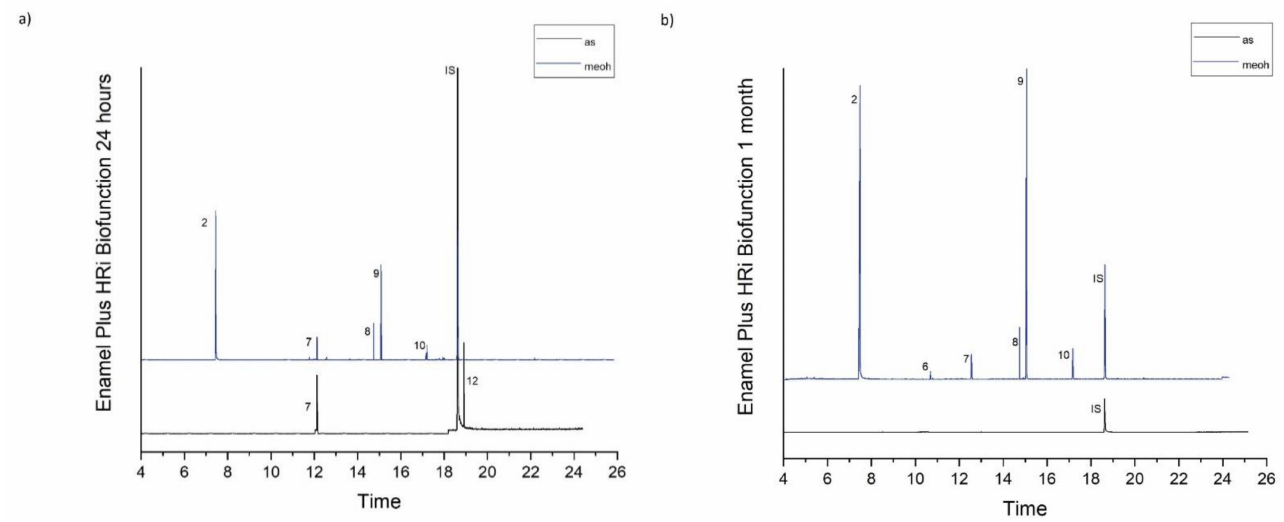
Figure 3. ( a , b ). Chromatograms of Enamel Plus HRi Biofunction in artificial saliva and methanol for both observation periods (24 h and 1 month).